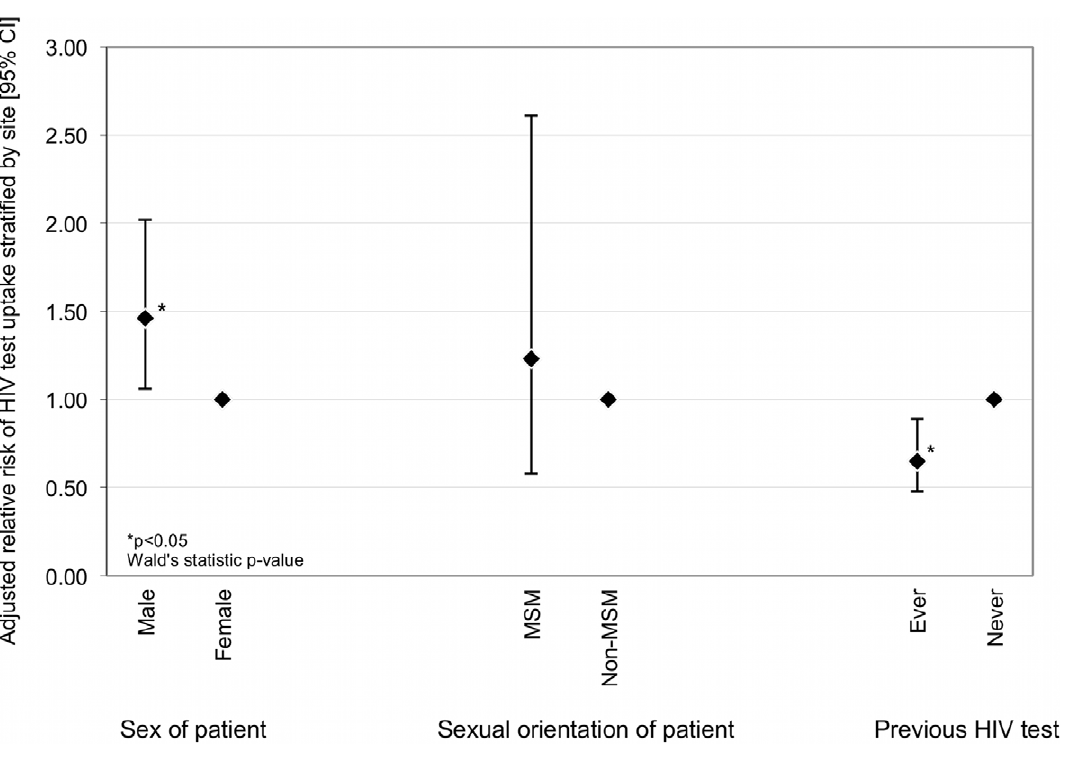
Figure 3. Multivariable logistic regression model showing potential predictors of HIV test uptake in patients who completed the questionnaire. (n=1003; adjusted for age, ethnicity and other variables in the model, and stratified by site; MSM=men who have sex with men).